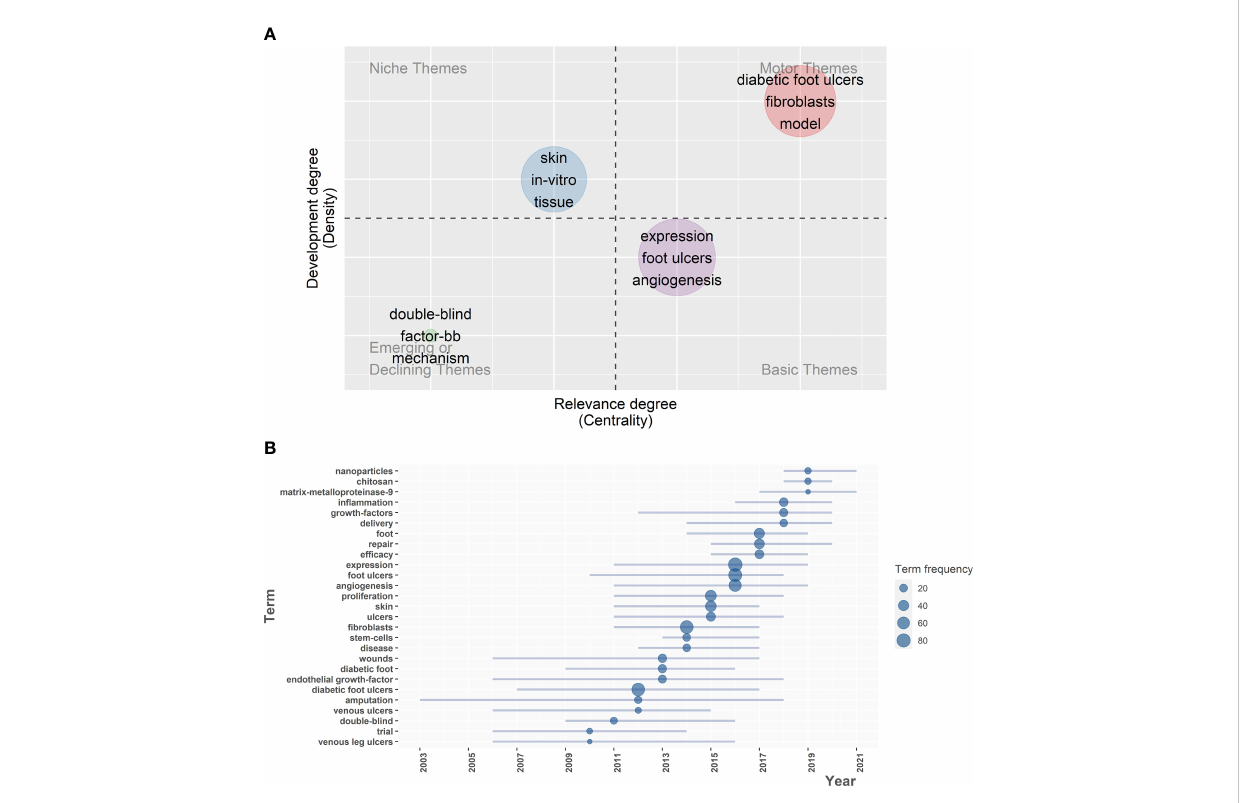
FIGURE 5 Exploring research status of various hot topics on fi broblast-related DFUs, sketching historical trajectories and revealing research frontiers. (A) Thematic map for fi broblast-related DFUs research. The horizontal coordinate refers to the relevance degree (centrality), and the vertical coordinate represents the development degree (density). Motor themes in the fi rst quadrant represents core themes with high centrality and maturity, niche themes in the second quadrant represent isolated themes with increased maturity, the third quadrant represents emerging or declining themes with low centrality and high maturity, and basic themes in the fourth quadrant means popular themes with low maturity. (B) Trend topics map for fi broblast-related DFUs research. Showing trends in the occurrence of high frequency keywords for fi broblast-related DFUs